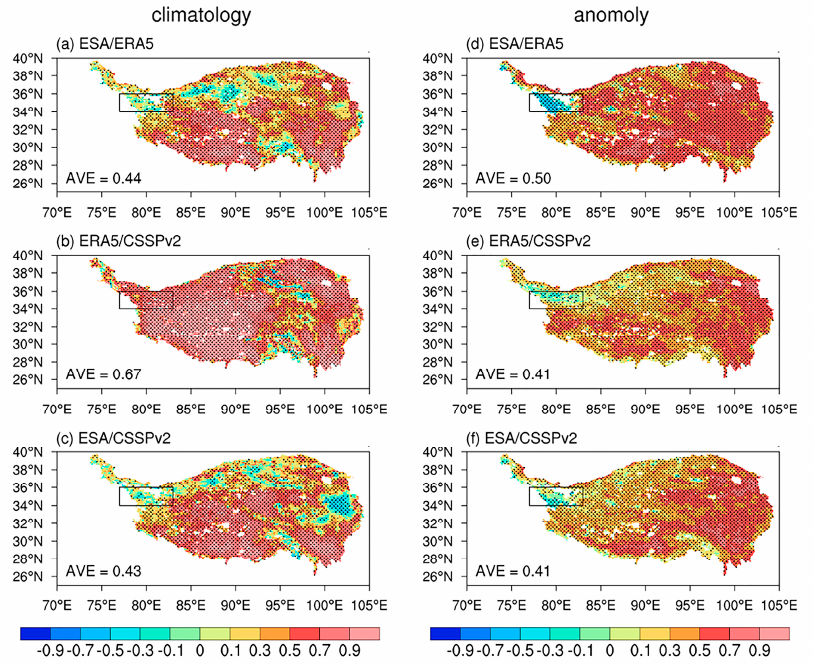
Figure 5. Correlation coefficients among soil moisture data of ESA, ERA5, and CSSPv2 in the study area. AVE means the spatial average and the dotted area means those grids passing the 95% significance test. ( a – c ) Correlation coefficients for the daily soil moisture climatology; ( d – f ) correlation coefficients for the soil moisture anomaly. The black rectangle masks out the northwestern part of QTP, where the correlation coefficient is relatively low.